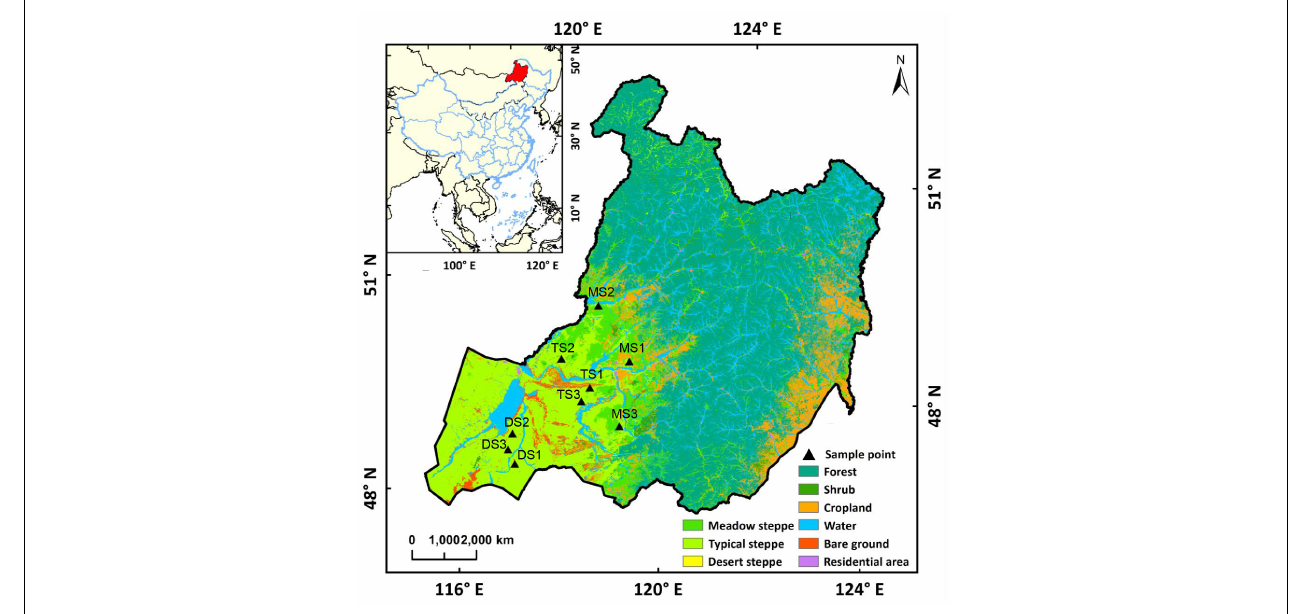
FIGURE 1 | Location of the sampling sites. Each sampling site includes a paired grazing site and grazing exclusion site. MS1, MS2, and MS3 refer to the sampling sites in meadow steppe; TS1, TS2, and TS3 refer to the sampling sites in typical steppe; DS1, DS2, and DS3 refer to the sampling sites in desert